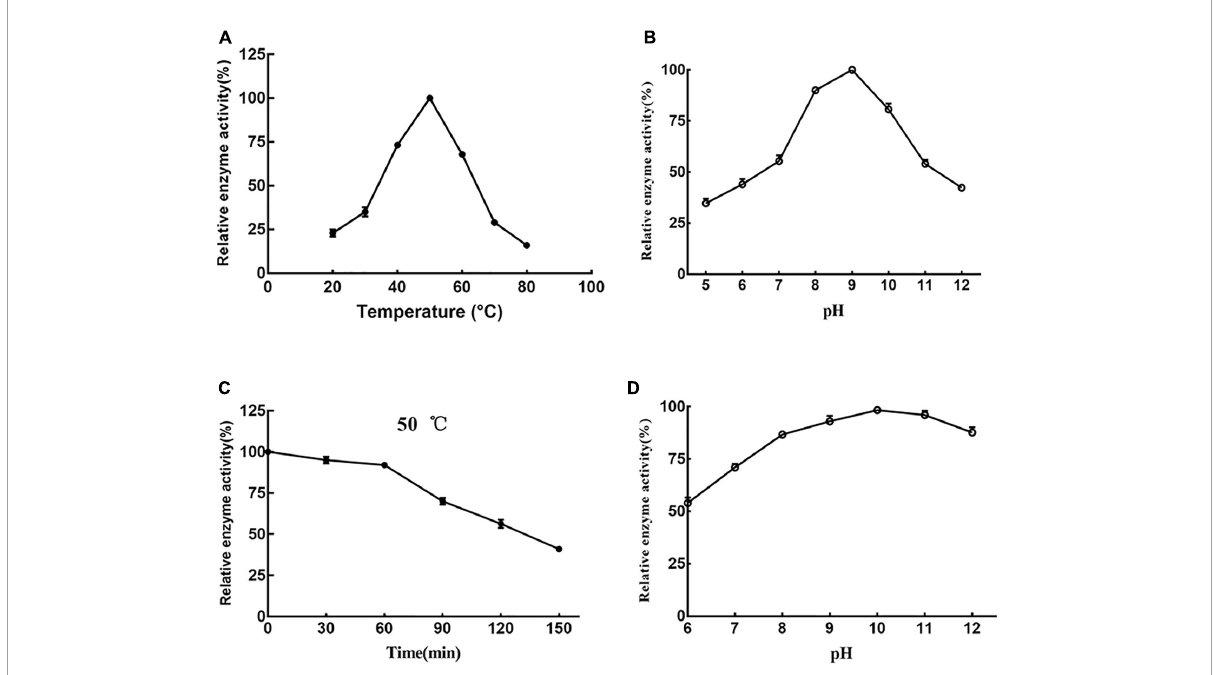
FIGURE5 Effects of temperature and pH on prot DS5. Optimum reaction temperature (A) and pH (B) of the enzyme; (C) the stability of the enzyme at 50 ◦ C; (D) stability of the enzyme at different pH. Each point represents the mean ( n = 3) ± standard